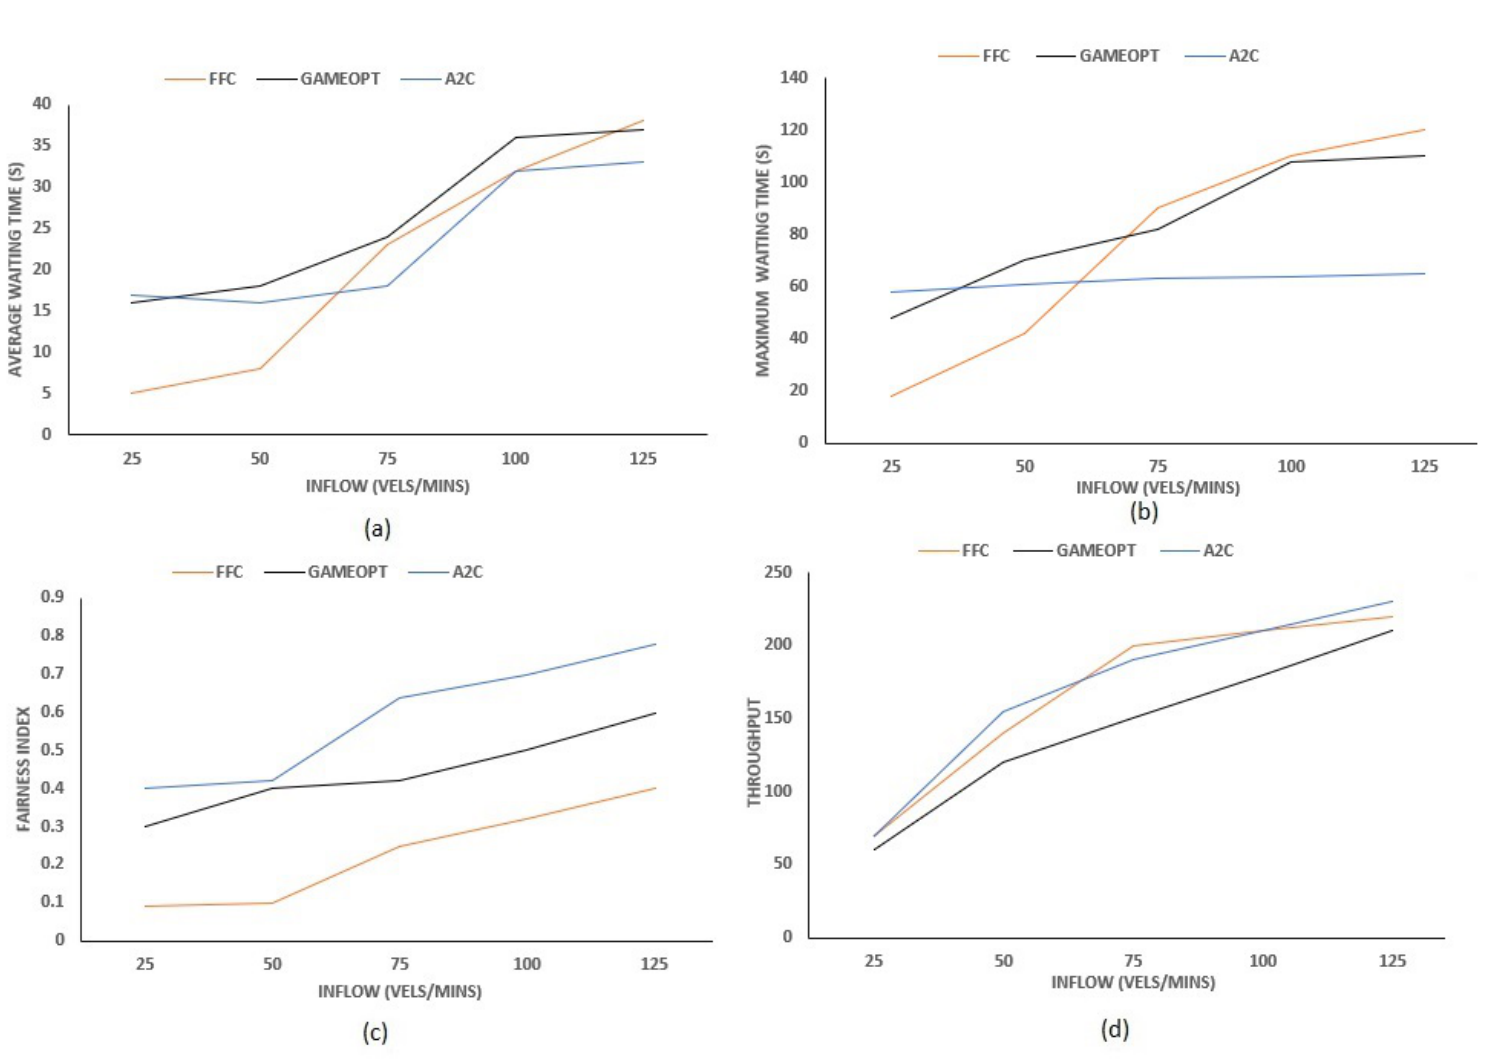
Figure 12. Performance results for different inflow rates: ( a ) AWT, ( b ) MWT, ( c ) Fairness, ( d )